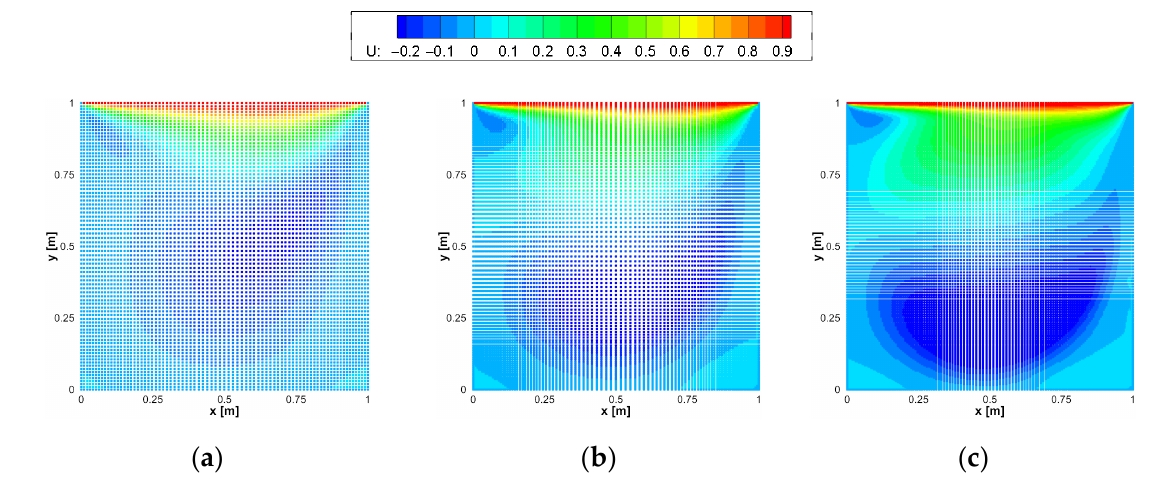
Figure 5. Contour maps of u for Re values of ( a ) 100, ( b ) 400, and ( c ) 1000.